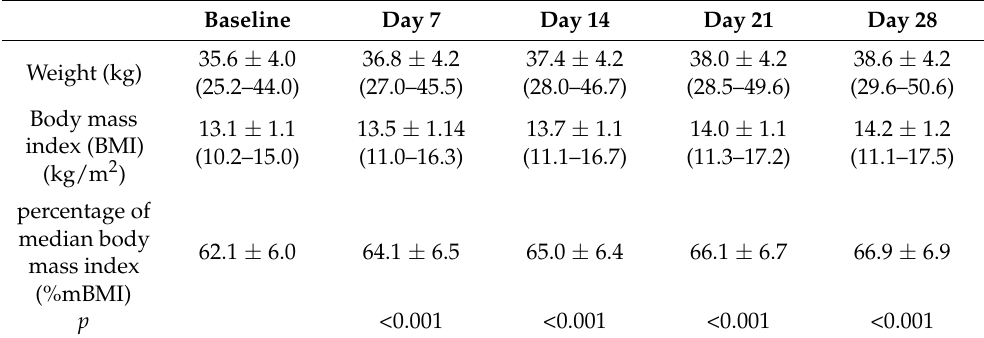
Table 4. Weight and Body Mass Index (BMI)